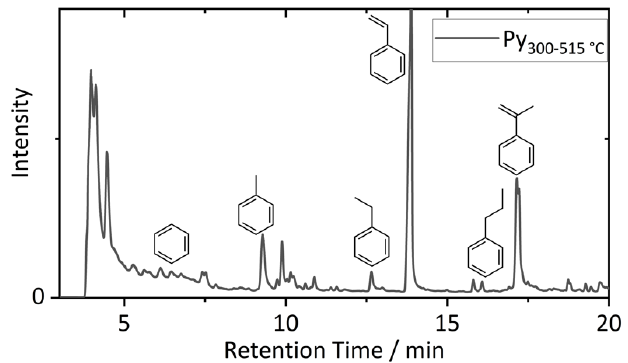
Figure 5. Py-GC-MS pyrogram (515 °C pyrolysis temperature) of the untreated shredded material. SBR-originating compounds are marked. The shown “fingerprint” was used for the targeted identification of the SBR in the treated material.